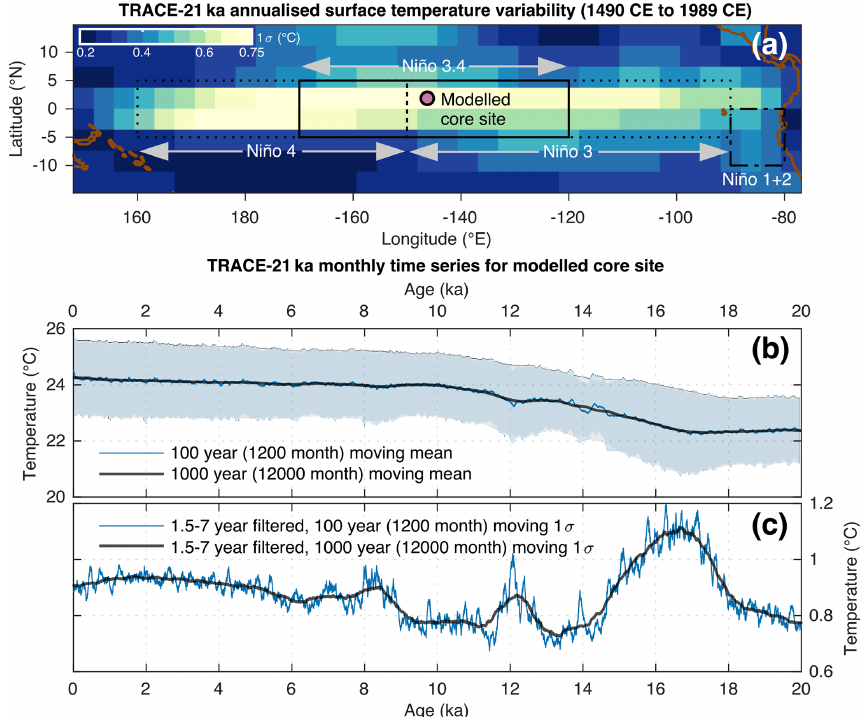
Figure 1. Overview of the modelled core site location and associated TRACE-21ka data. (a) The location of the modelled sediment core site superimposed upon the standard deviation of annualised SST from the TRACE-21ka for the 500 year period between 1490CE and 1989CE. Also shown for reference are the Niño regions 1 + 2, 3, 3.4 and 4. (b) 100 year (1200 month) and 1000 year (12000 month) moving mean of the monthly TRACE-21ka SST data for the modelled sediment core site. Also shown in light blue and light grey are the moving ± 1 σ envelopes associated with the moving 100 year (1200 month) and 1000 year (12000 month) windows, respectively. (c) 100 year (1200